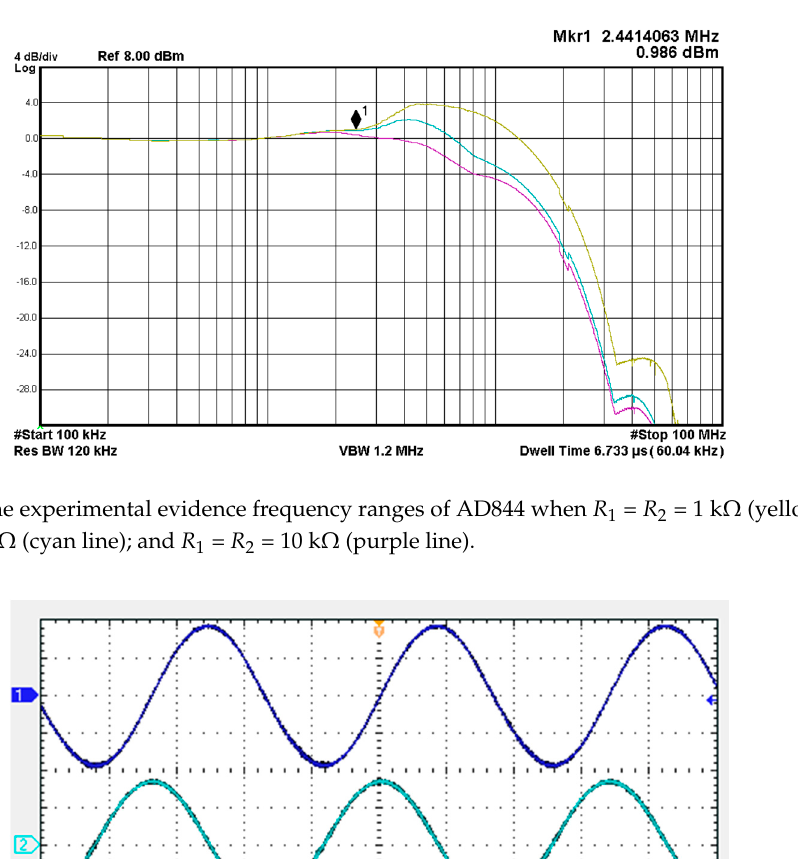
Figure 13. Tested frequency range of AD844.